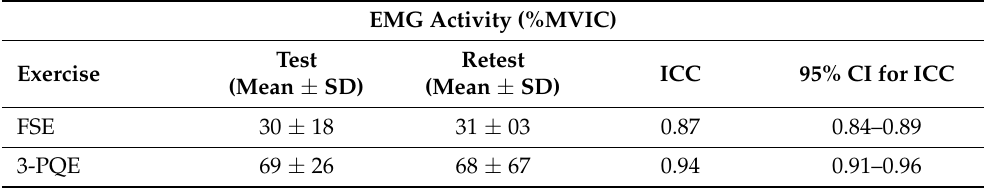
Table 3. EMG activity of the LM muscle during FSE and 3-PQE ( n = 64).